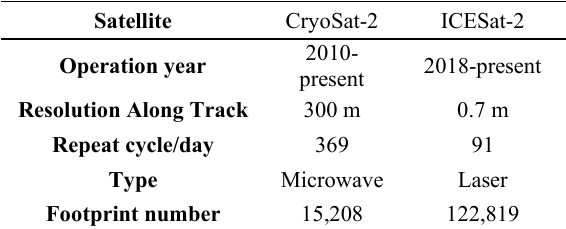
Table 1 . Parameters of altimetry satellites.